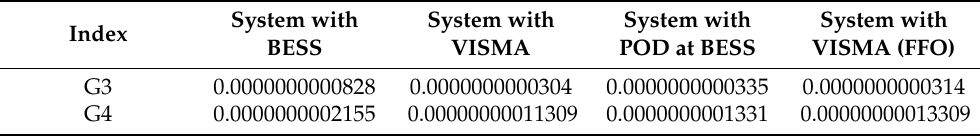
Table 11. TKE comparison under different